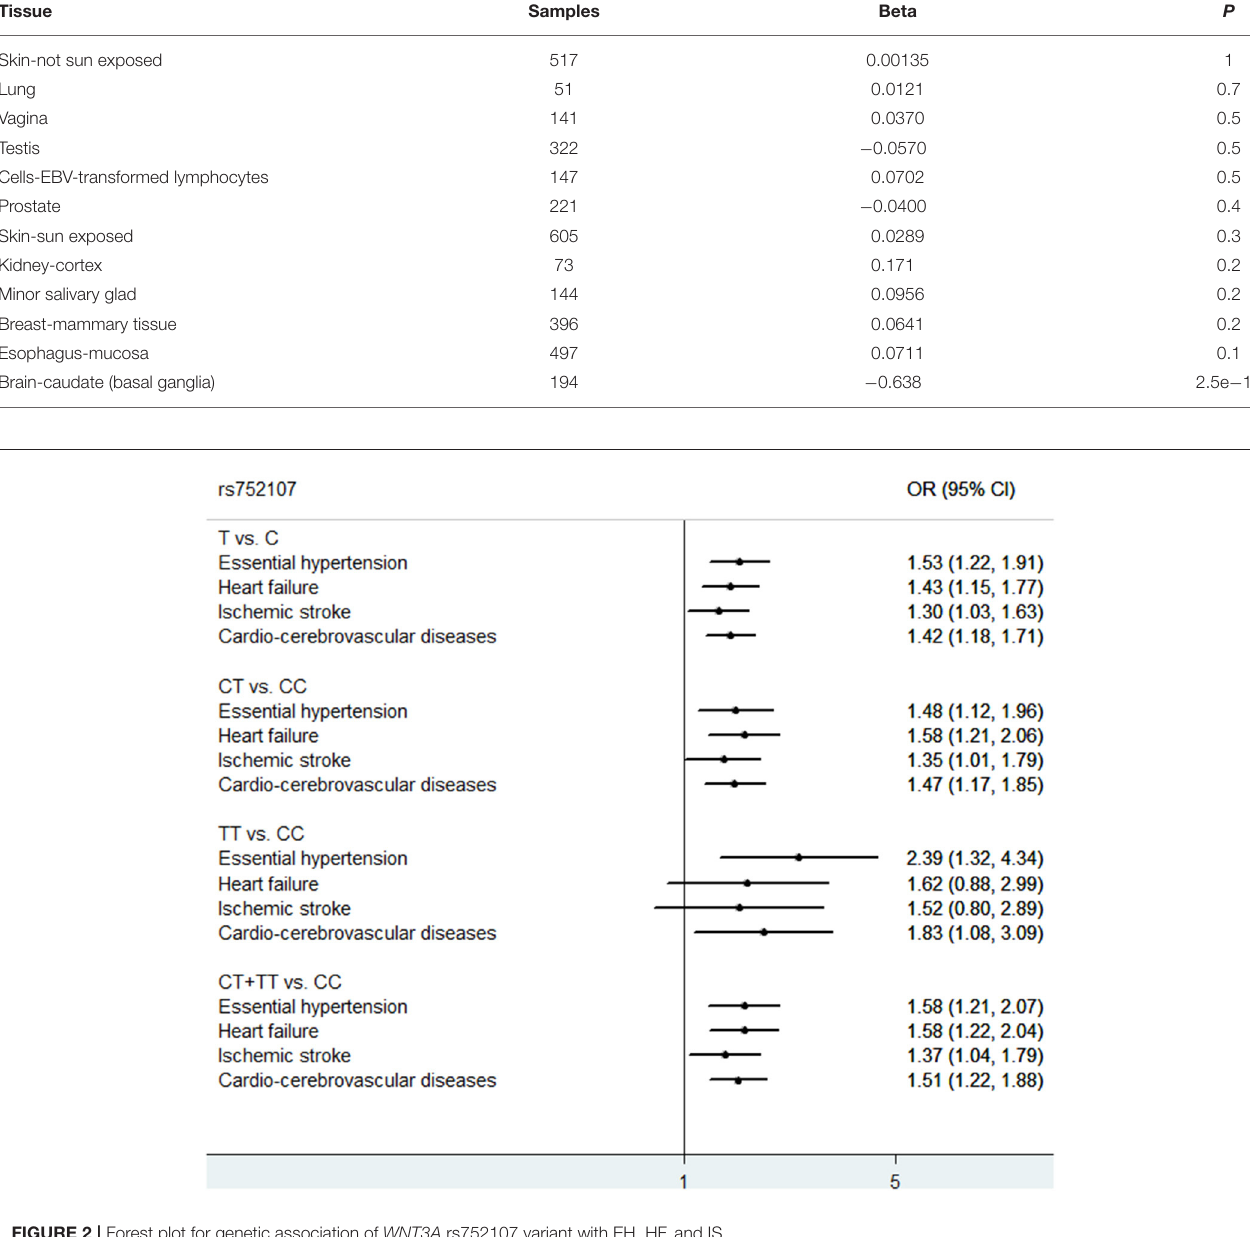
protein (FRZB)- a secreted Wnt antagonist (19), secreted frizzled- related proteins (SFRP)- a competitive antagonist of Wnt